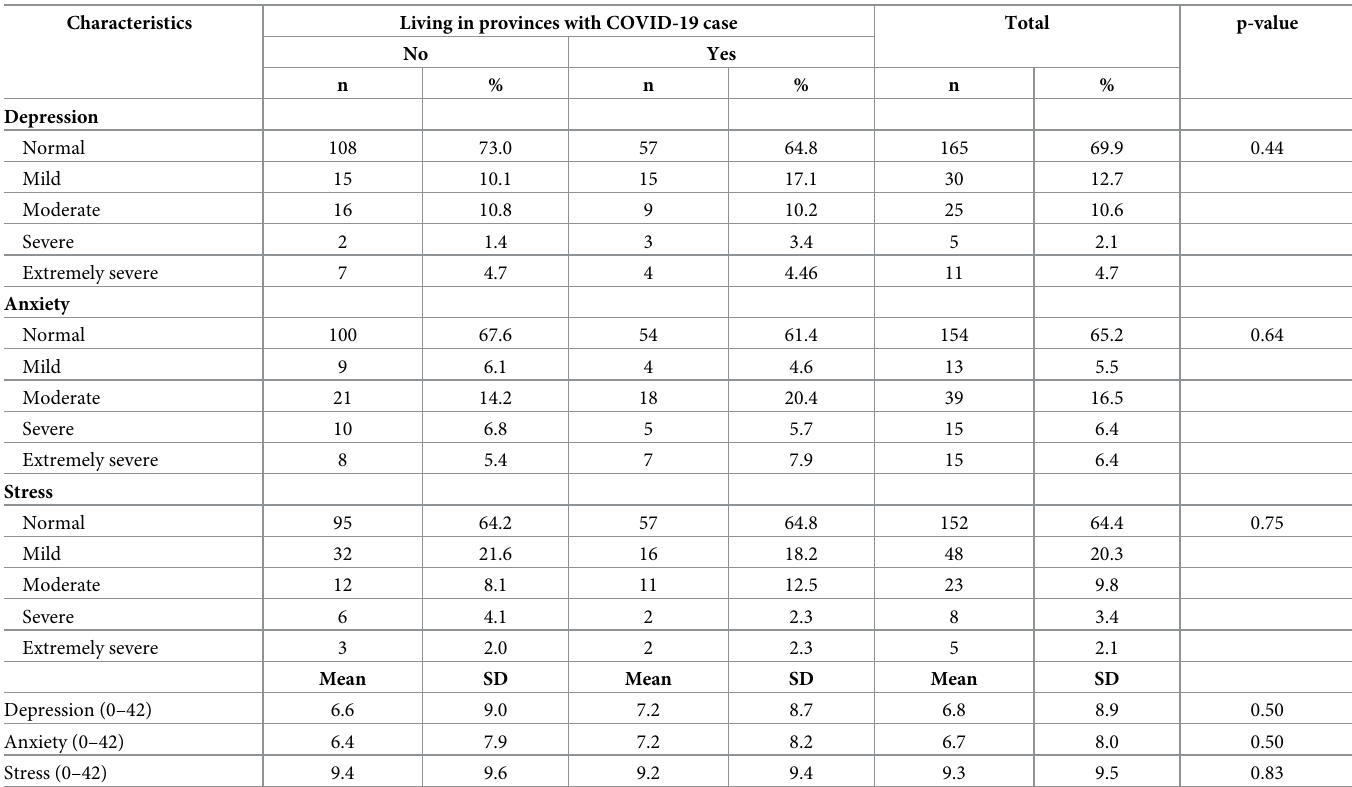
Table 2. Anxiety, depression, and stress patterns (n =